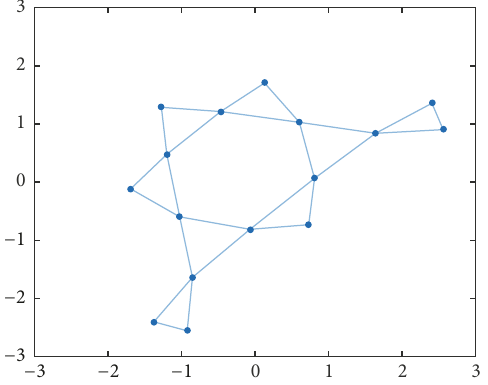
Figure 5: Regular triangular oxide network RTOX(2).